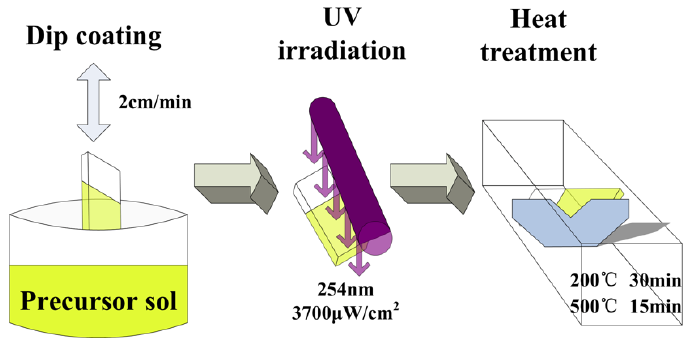
Figure 1. Schematic diagram of the preparation process of TiO 2